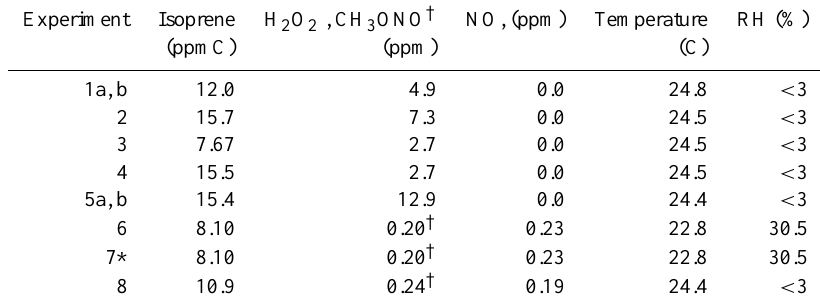
Table 1. Initial conditions for the formation of secondary organic aerosol from the photooxidation of isoprene in the absence and presence of NO x . CH 3 ONO and H 2 O 2 served as the OH precursors in experiments with and without NO x ,